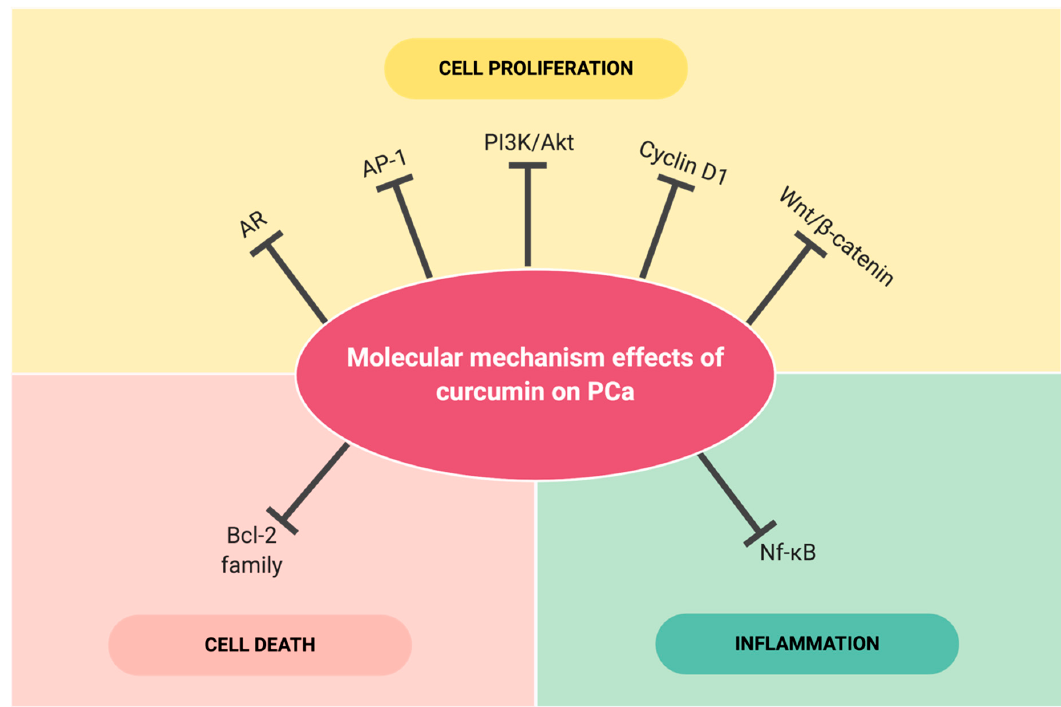
Figure 3. The key molecular targets of curcumin linked with inflammation, cell death, and cell proliferation in in vitro and in vivo models of PCa. The sign ⊣ indicated inhibition by curcumin. AR: Androgen receptor signalling; AP-1: Activating protein-1; PI3K/Akt/mTOR: Phosphatidylinositol 3-kinases / the serine / threonine kinase; Wnt / ß: Wingless (Wnt) / ß-catenin signalling, and molecular targets: NF- κ B; Nuclear factor kappa-B; Bcl-2: B-cell lymphoma 2 and Cyclin D1.